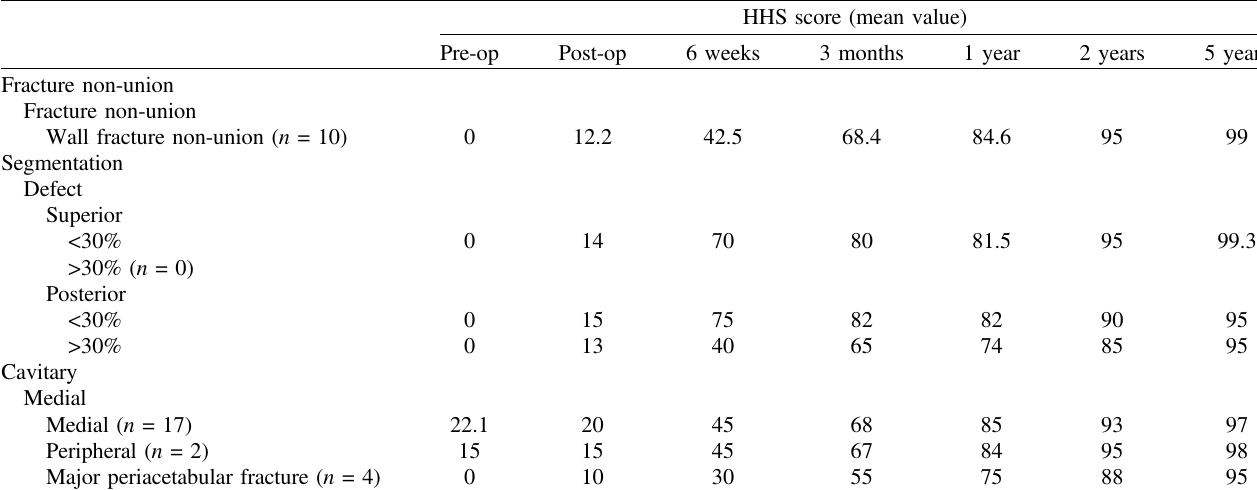
Table 3. Post-operative HHS scores by injury